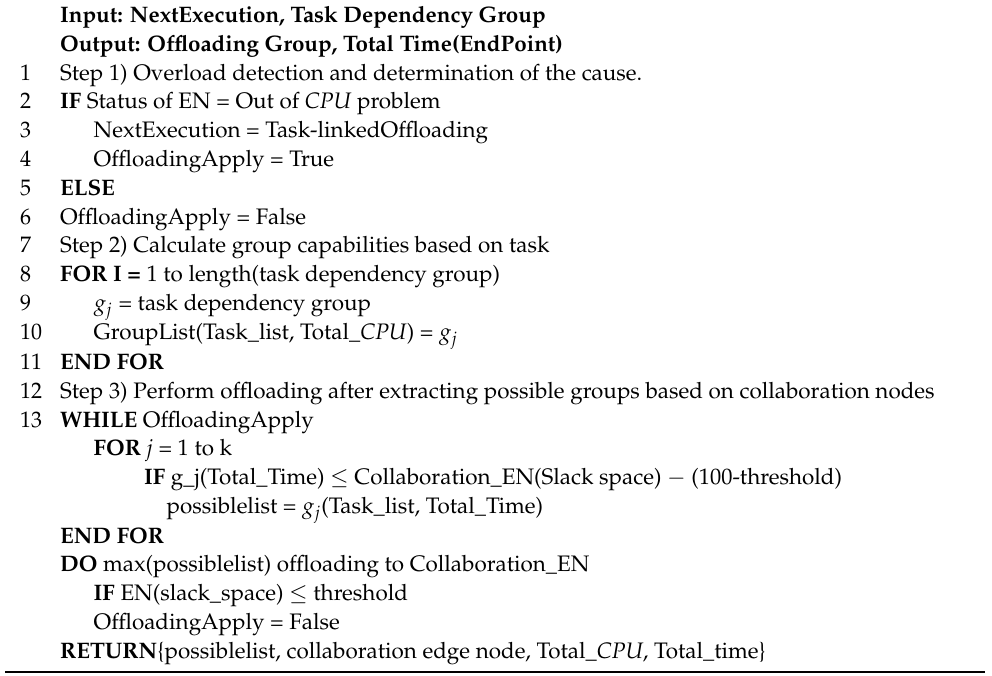
Algorithm 2 Task-Linked offloading